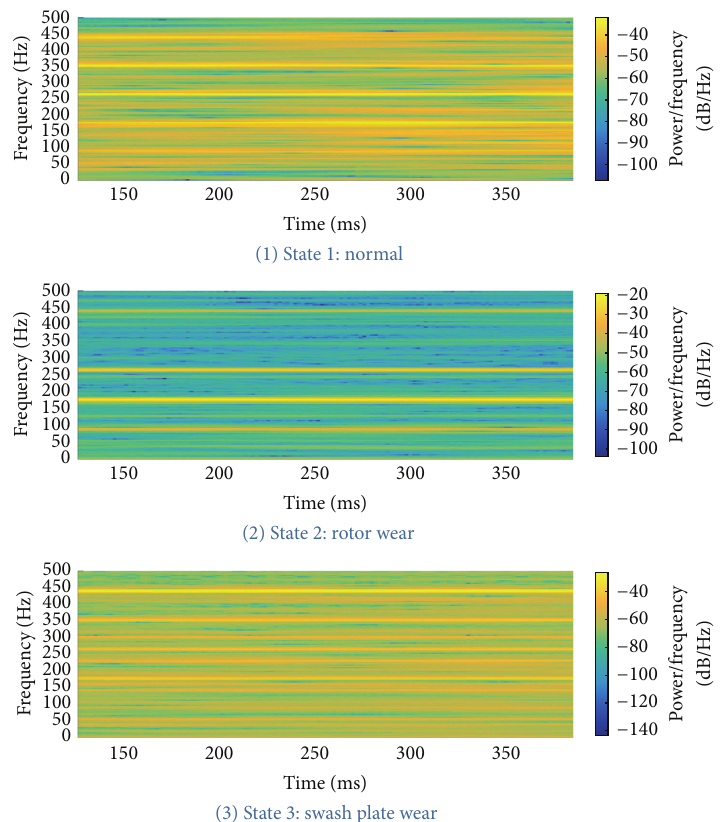
Figure 5: Spectrograms of the first IMF of each state.